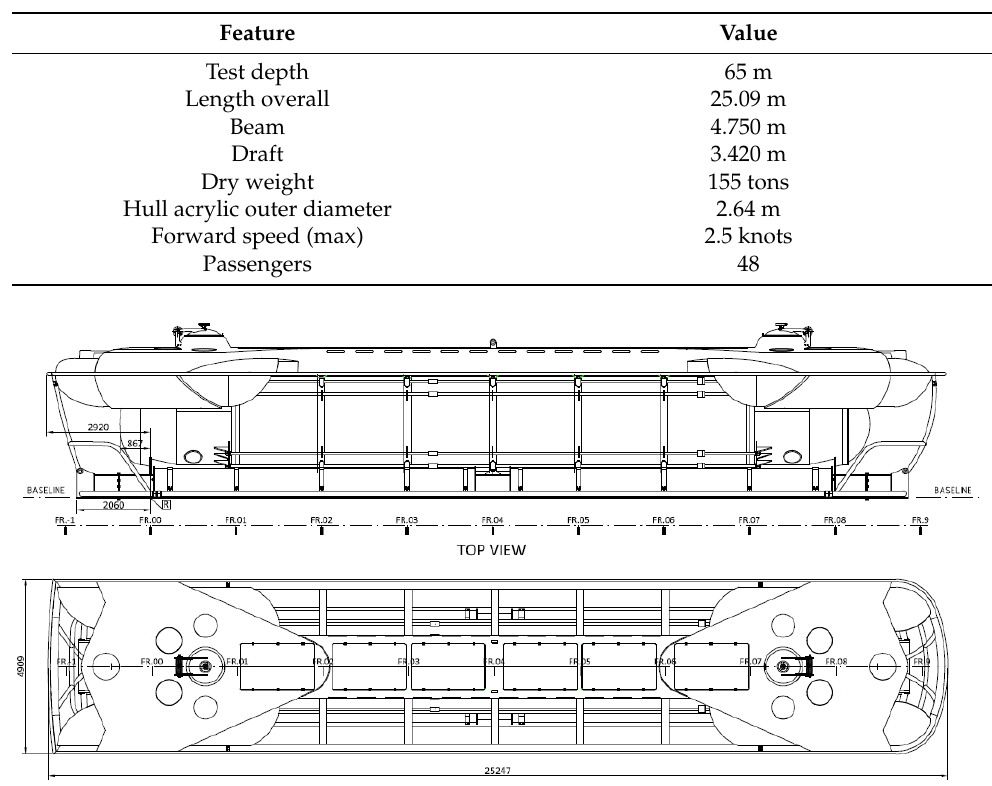
Table 1. The particulars of the submersible.